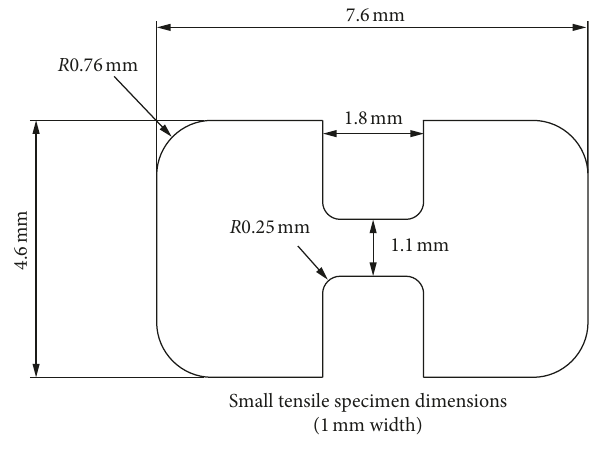
Figure 2: Minitensile specimen